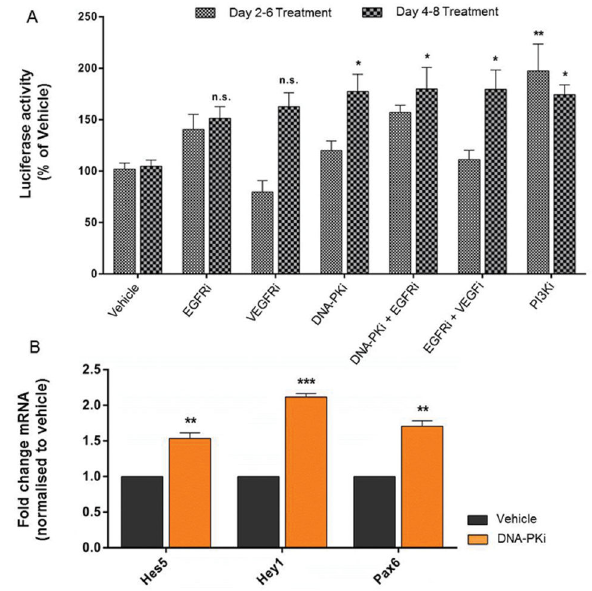
Figure 6. Small molecules can regulate Lmx1a activity and the Notch pathway after PA6-mediated neural